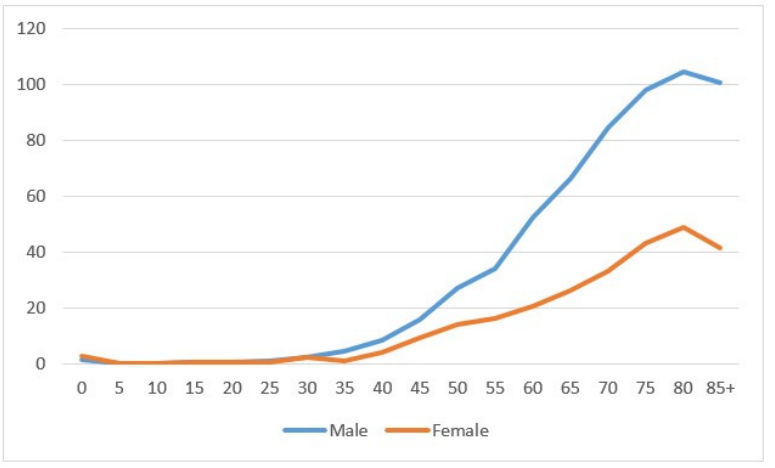
Figure 1. Age-specific incidence rate by sex in the Province of Reggio Emilia in the period 1996–2020. The figure shows the incidence specific rates for five-year classes for males (blue line) and females (orange